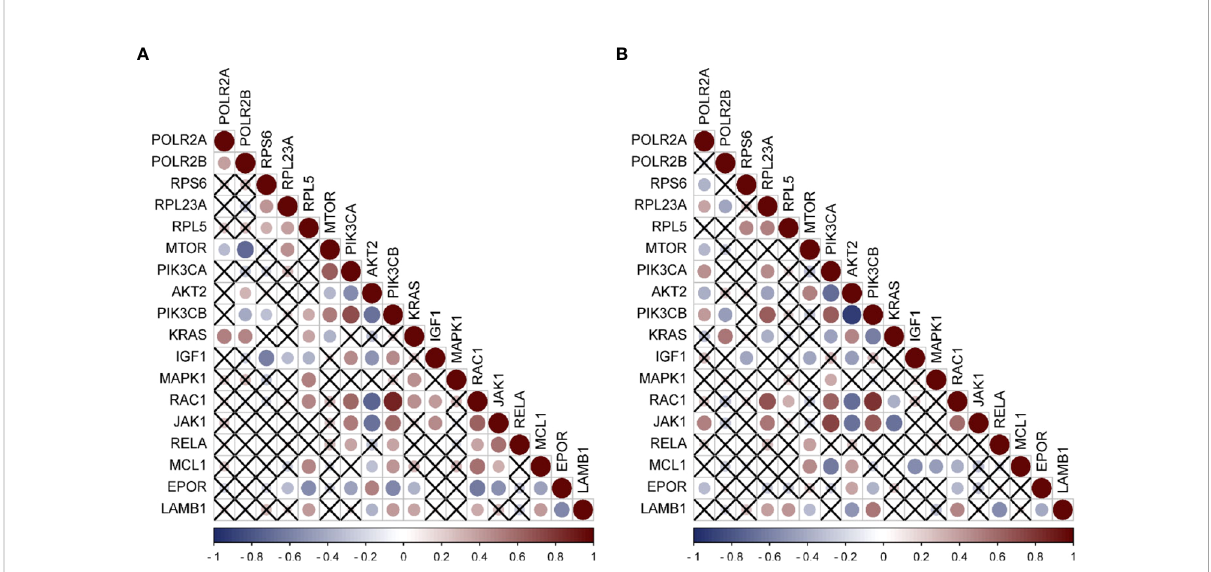
FIGURE 6 Expression correlation analysis of hub genes and Immune related genes (A) Correlation analysis of HBV-HCC immune pathway related genes and hub genes by using GSE55092. (B) Correlation analysis of HCV-HCC immune pathway related genes and hub genes by using GSE69715. Red was positively correlated and blue was negatively correlated. The size of the circle represented the magnitude of correlation, and the cross indicated no correlation.